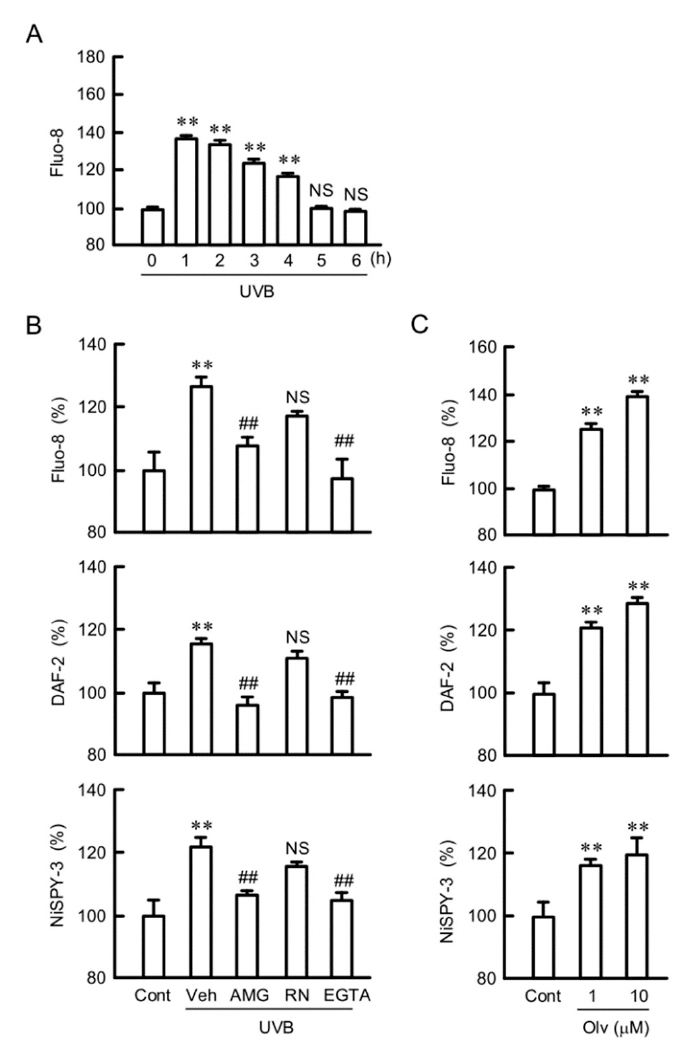
Figure 7. Involvement of transient receptor potential type vanilloid 1 (TRPV1) in the UVB-induced production of RNS. ( A,B ) After we exposed cells to weak UVB, the cells were incubated for 3 h in the absence (Veh) and presence of 10 µ M AMG9810 (AMG), 10 µ M RN1734 (RN), or 2 mM glycoletherdiaminetetraacetic acid (EGTA). ( C ) Cells were incubated for 3 h in the absence (Cont) and presence of olvanil (Olv). The cells were incubated with 5 µ M Fluo-8 AM, 5 µ M DAF-2DA, or 5 µ M NiSPY-3 for 30 min. The fluorescence intensities of Fluo-8, DAF-2, and NiSPY-3 were measured using a plate reader. n = 8. ** p < 0.01 vs. Cont. ## p < 0.01 and NS p > 0.05 vs. Veh.